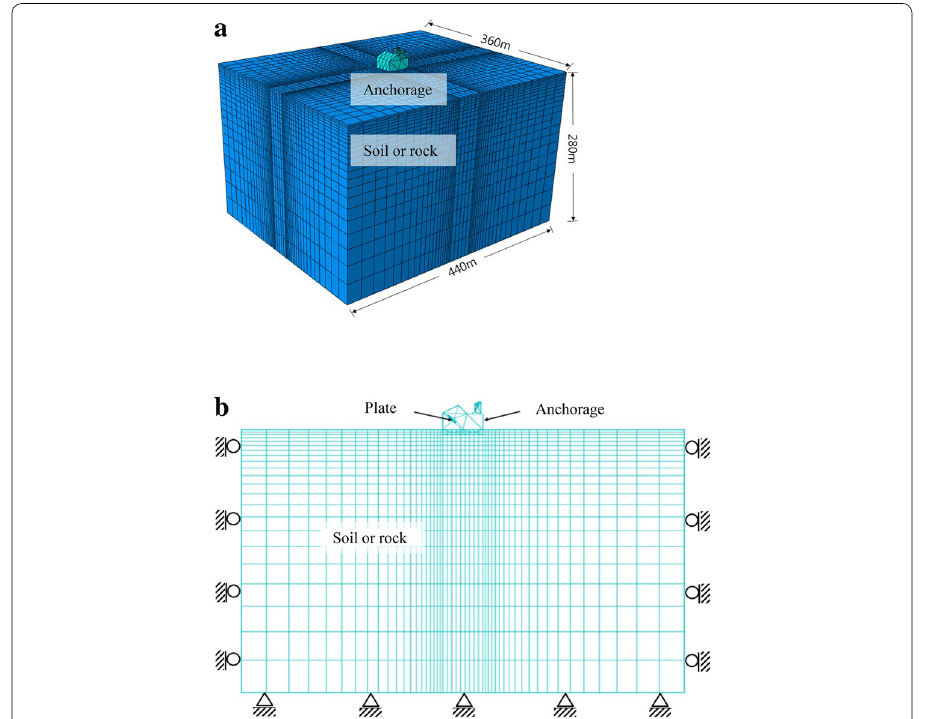
Fig. 1 Representative finite element mesh used in the analysis: a typical 3D FE mesh; and b cross-section view and boundary